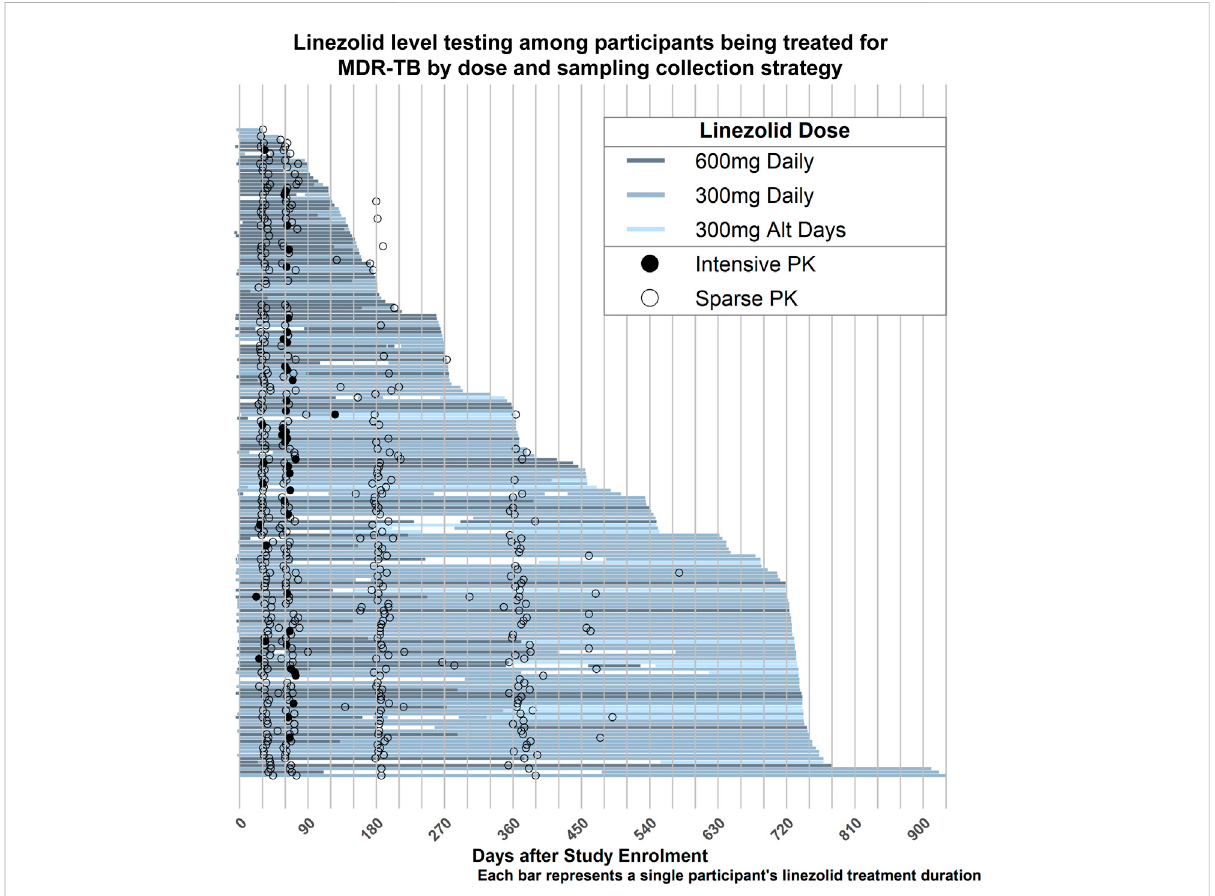
FIGURE 1 Duration of linezolid treatment. Each horizontal line represents a single participant, with the colour coding denoting the dose of linezolid prescribed over that time period. Most participants were treated for 24-month, though dose adjustments frequently occurred due to treatment- associated toxicity. Filled circles indicate intensive sampling visits and open circles indicate sparse sampling